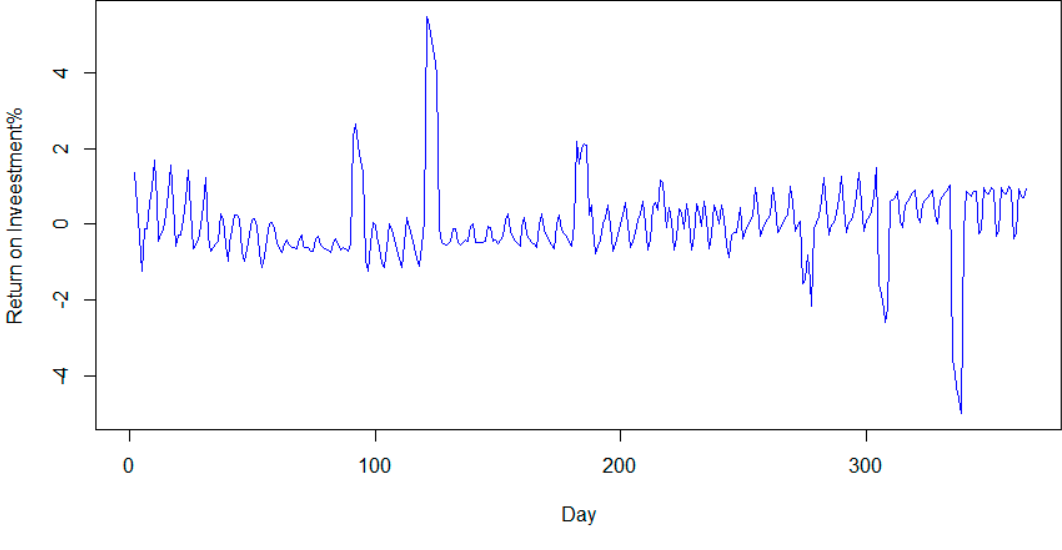
Figure 7. Daily return for ratio.